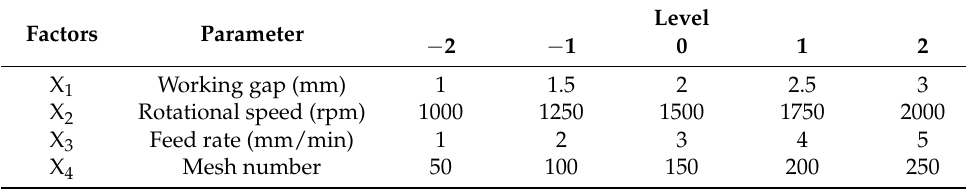
Table 3. Parameters and levels for experiment.